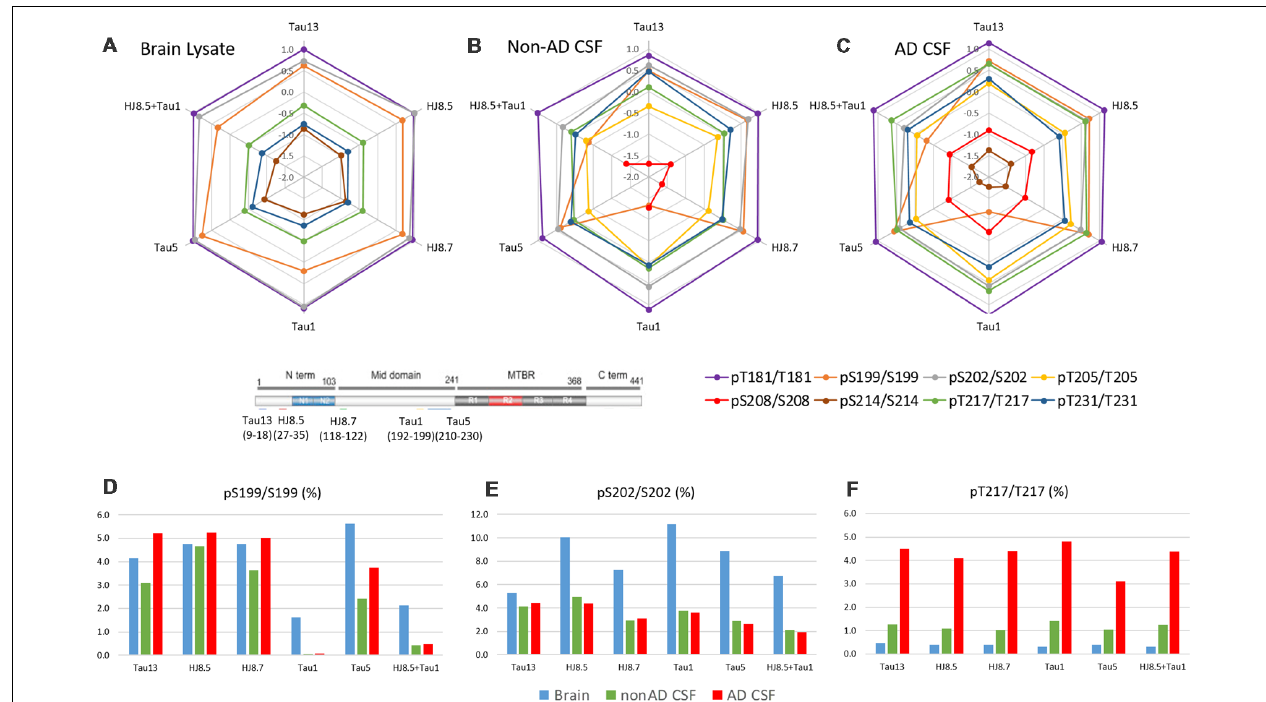
FIGURE 13 | Antibody effect on phosphorylation ratio measurement by IP-MS. Brain lysate pool, non-AD ( n = 1) and AD CSF ( n = 1) pools were immunoprecipitated in parallel with antibodies against tau N-terminus projection domain (Tau13 or HJ8.5) or mid-domain (HJ8.7, Tau1 or Tau5). Radar plots of phosphorylation ratios measured on main CSF sites (log 10 scale) are shown in brain lysate (A) , non-AD CSF (B) and AD CSF (C) . (A–C) Tau phosphorylation ratio measurements on pT181/T181, pT231/T231 are consistent across antibodies tested. PS199/S199 is decreased by using Tau1 or Tau1+HJ8.5 in comparison to other antibodies. (D) Low recovery of pS199 by Tau1 or Tau1+HJ8.5 IP underestimate pS199/S199 ratio measurements compared to other antibodies tested. Tau13, HJ8.5, and HJ8.7 antibodies indicate no significant changes of pS199 phosphorylation ratio between brain and CSF. Compared to brain, pS202/S202 CSF